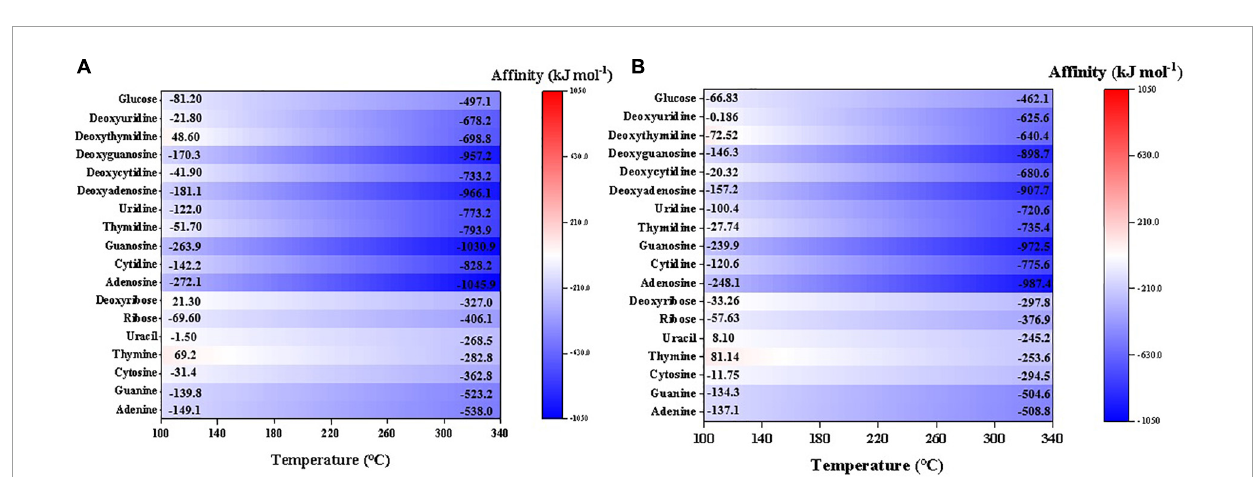
FIGURE7 Synthesis affinity of sugar, nucleobases and nucleosides using (A) CO, g and (B) CO 2 , g as carbon source.